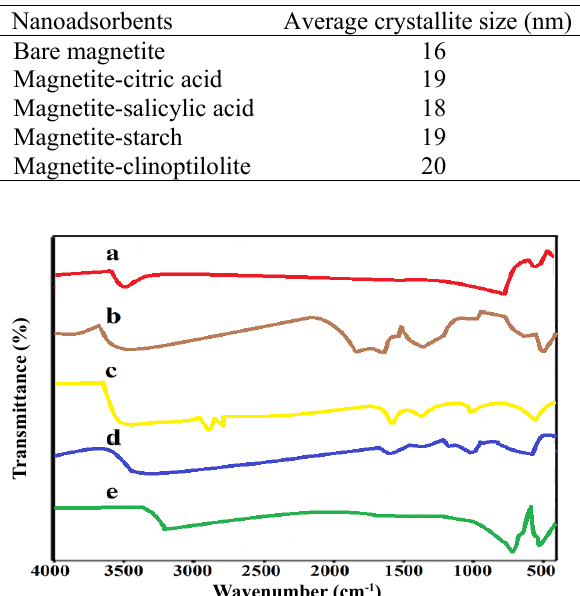
Fig. 3. FT-IR spectra of (a) bare magnetite, (b) magnetite-citric acid, (c) magnetite-salicylic acid, (d) magnetite-starch and (e) magnetite-clinoptilolite